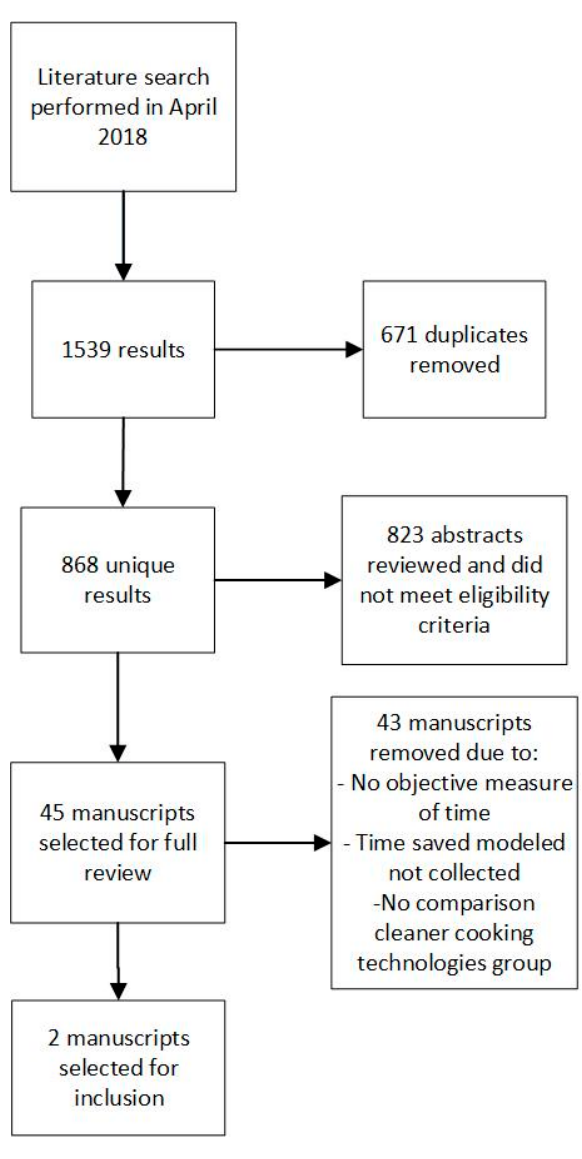
Figure 1. Preferred Reporting Items for Systematic Reviews and Meta-Analyses (PRISMA) diagram.